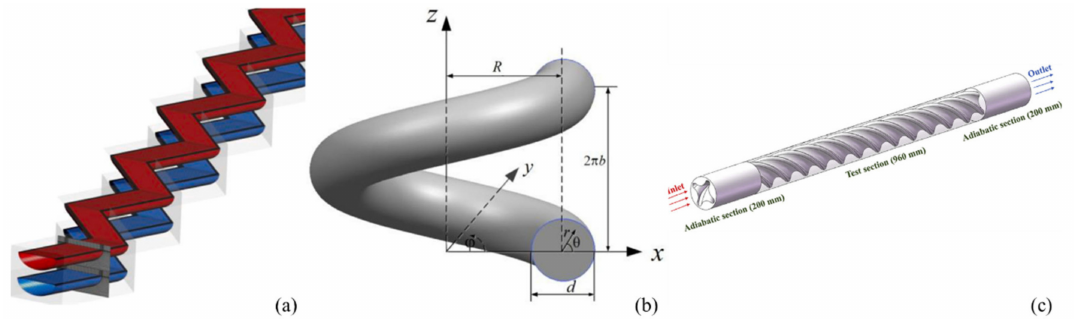
Figure 12. Physical model of semi–circular channels [59] ( a ), helically coiled tubes [60] ( b ), and fluted tubes [61] ( c